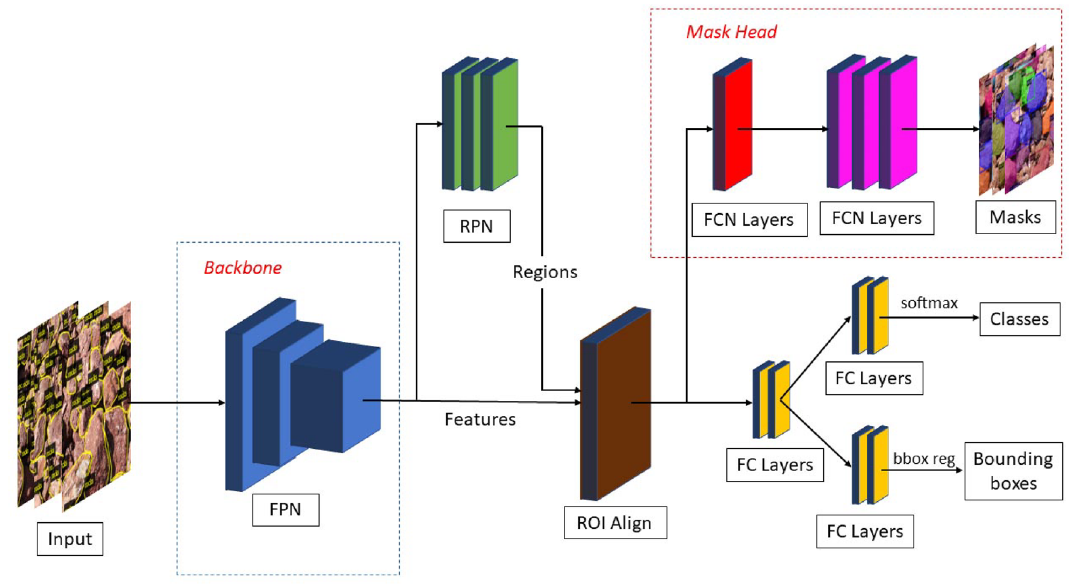
Figure 3. Framework of Mask R CNN with ResNet and FPN as backbone